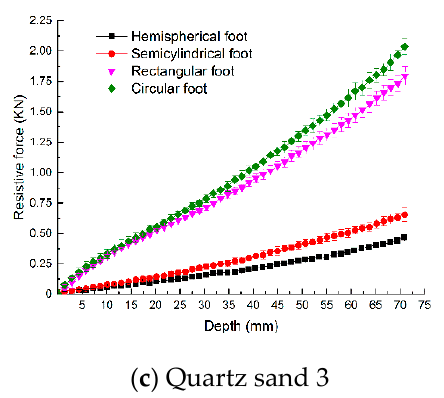
Figure 7. Comparisons of intrusion resistive forces for different feet.